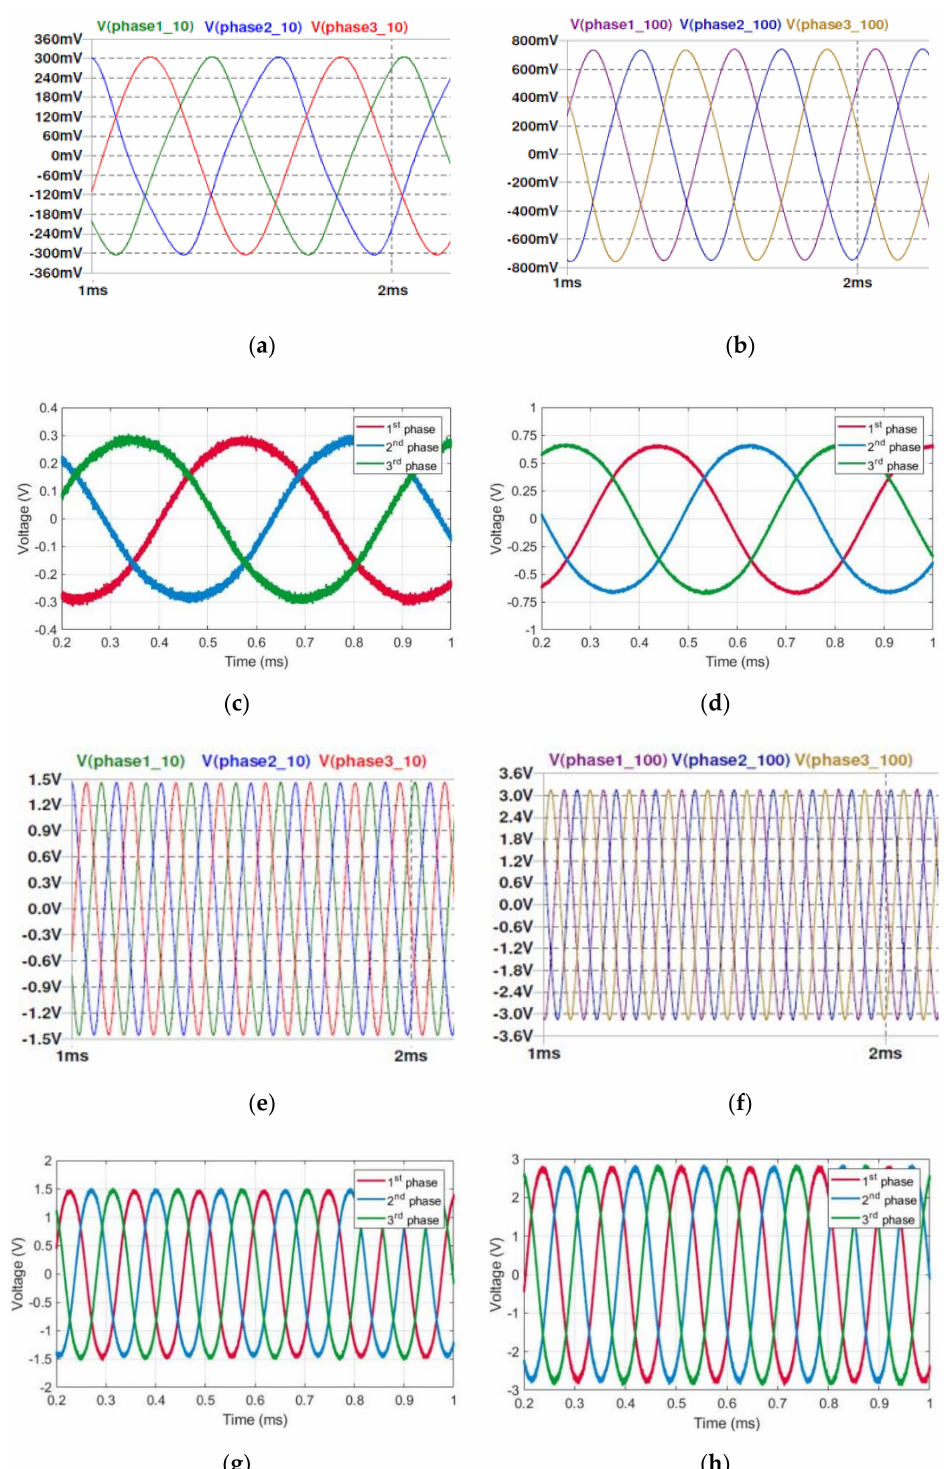
Figure 18. Linear Technology Spice (LTspice) model and real test results with 10 and 100 Ω loads and with 3 and 10 m / s wind flow velocities. ( a ) LTspice model results with 10 Ω loads and 3 m / s wind flow velocity. ( b ) LTspice model results with 100 Ω loads and 3 m / s wind flow velocity. ( c ) Real test results with 10 Ω load and 3 m / s wind flow velocity. ( d ) Real test results with 100 Ω load and 3 m / s wind flow velocity. ( e ) LTspice model results with 10 Ω loads and 10 m / s wind flow velocity. ( f ) LTspice model results with 100 Ω loads and 10 m / s wind flow velocity. ( g ) Real test results with 10 Ω load and 10 m / s wind flow velocity. ( h ) Real test results with 100 Ω load and 10 m / s wind flow